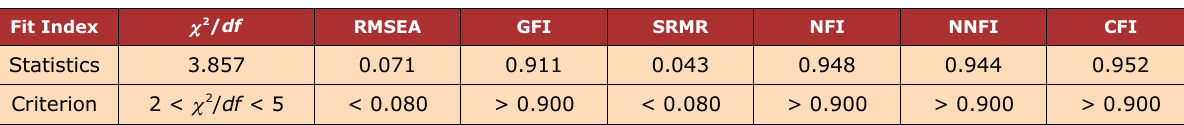
Table 5. Goodness-of-Fit Indices of the Model